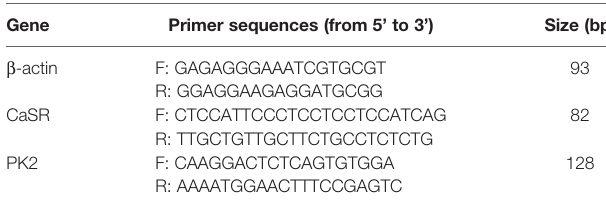
TABLE 1 | Sequences of primer pairs used in the real-time quantitative PCR